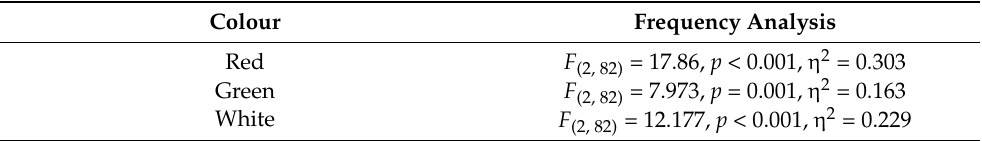
Table 4. Simple effects of the Frequency variable on SNR for the 1st harmonic, for the three